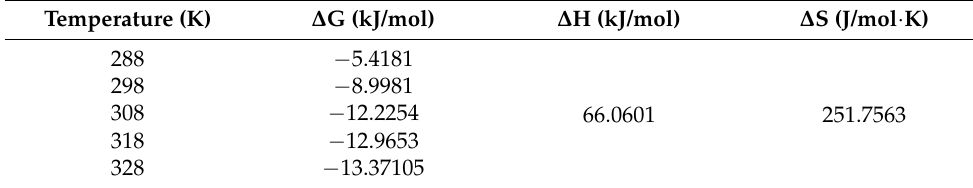
Table 8. Adsorption thermodynamic